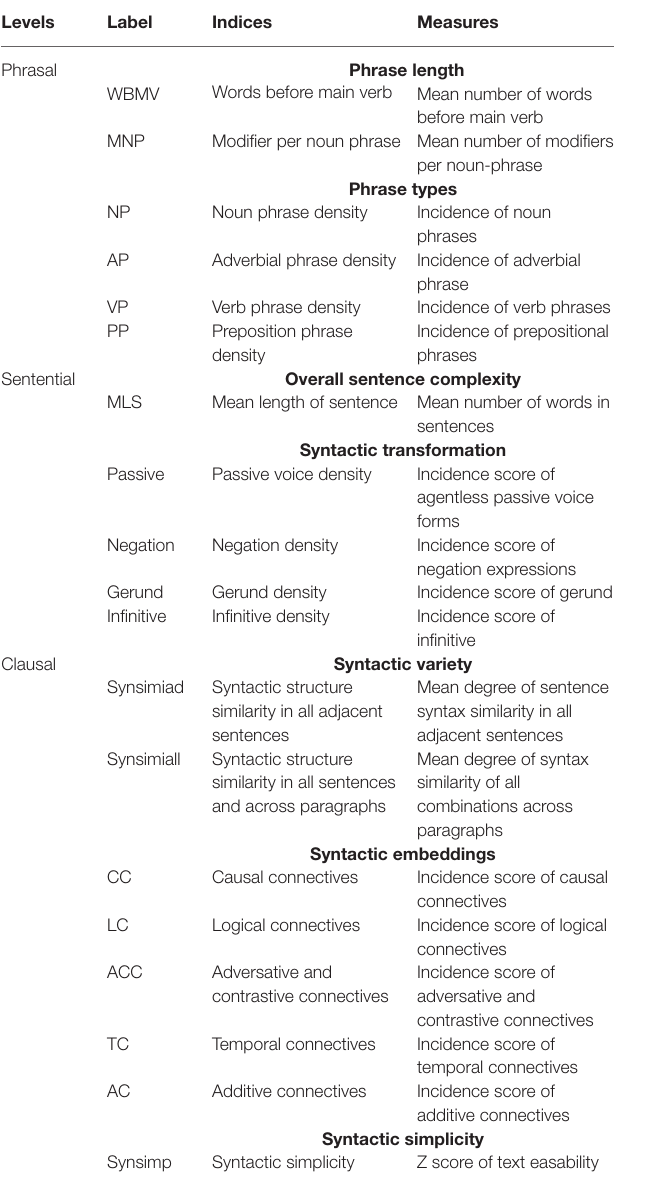
TABLE 1 | Seven dimensions of linguistic features derived by